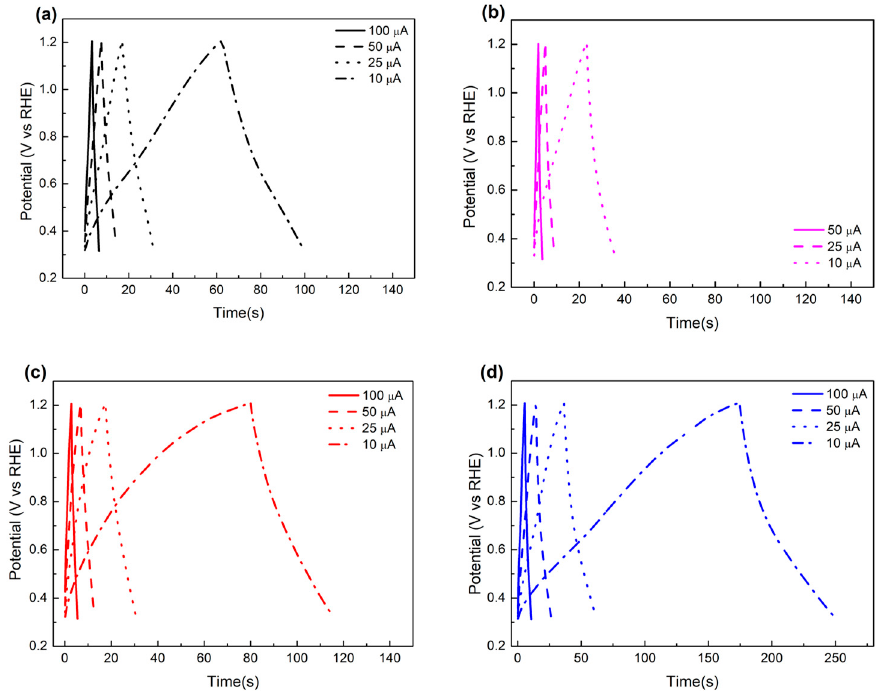
Figure 7. CDC responses of voltage of Vulcan XC-72 ( a ), CNF ( b ), MCF-A ( c ), and bulk MC ( d ) under different charging currents, where the X-axis for ( a ), ( b ), and ( c ) is 0–140 s, and the X-axis for ( d ) is 0–275 s, obtained in N 2 -saturated HClO 4 .